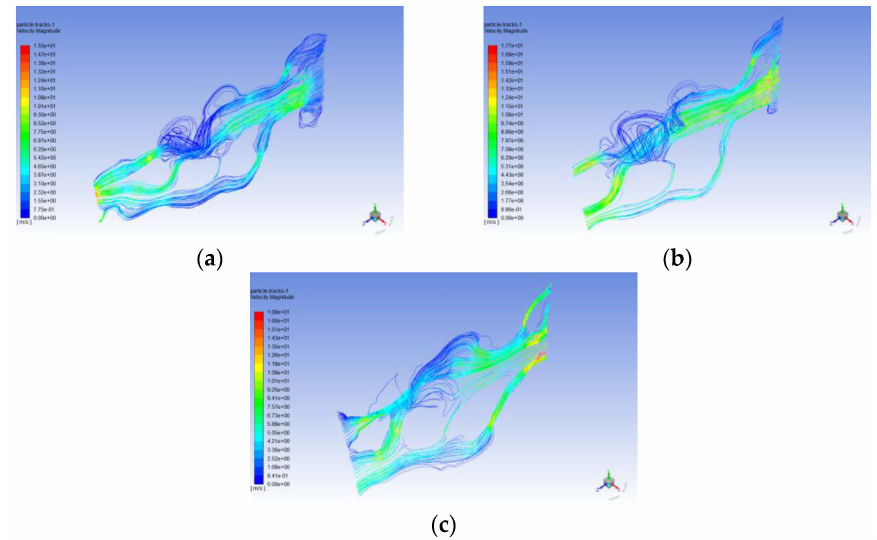
Figure 9. The 3 Mp pressure cloud and speed vector illustration: ( a ) fracture grid motion trajectory. ( b ) z forward motion trajectory diagram. ( c ) z negative motion trajectory